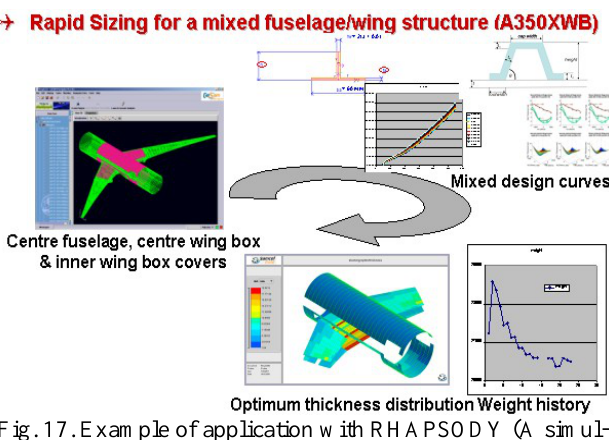
Fig. 17. Example of application with RHAPSODY (A simul- taneous optimization of wing and fuselage structures was performed successfully with different design curves) For commonality between different sizing levels inside the same interface we have kept the COMBOX framework for integration.